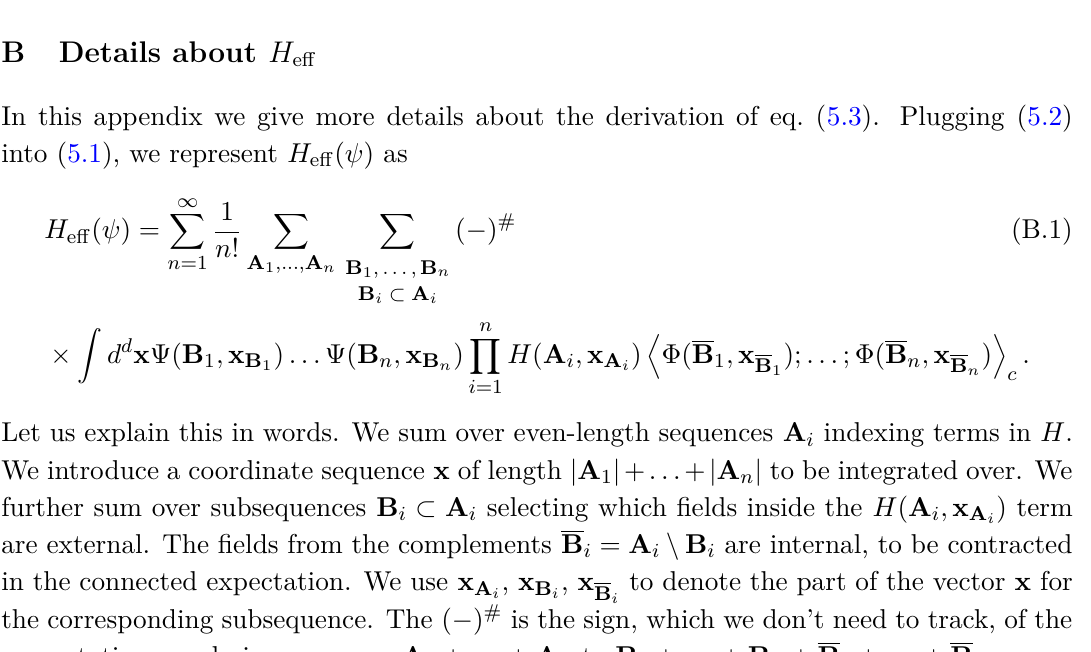
Figure 5. This figure represents a term in H eff corresponding to n = 1 in (B.1): just one vertex with | A | = 6 (gray oval). Empty circles are the external fields and filled circles are the internal ones. The generated H eff term has l = | B | = 2 . The 4 internal fields are contracted (just one possible contraction is